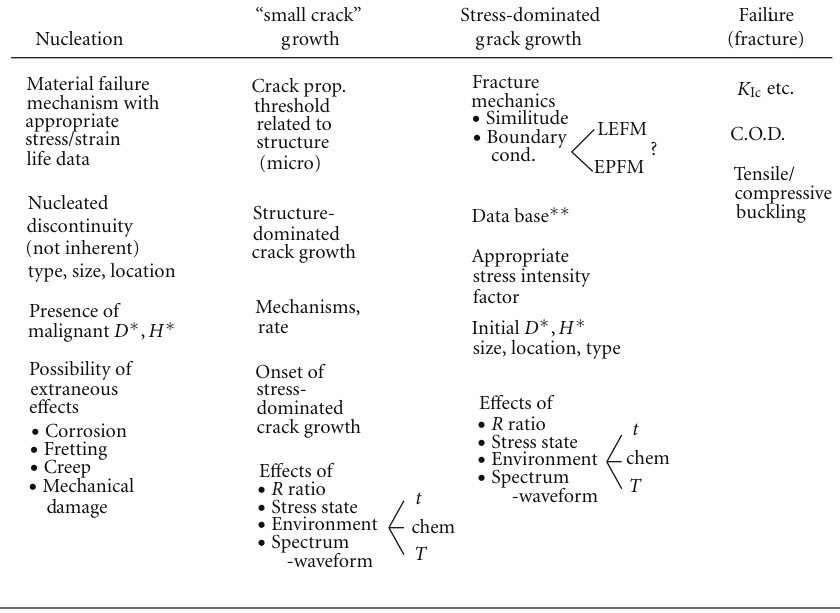
Figure 2: Methods for each life phase after Hoeppner-1972 [67], 1981 [38], 1985